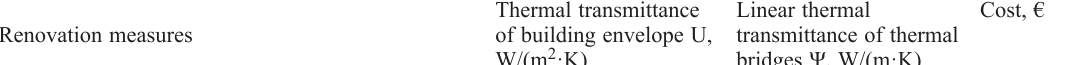
Table 2. Renovation measures and costs